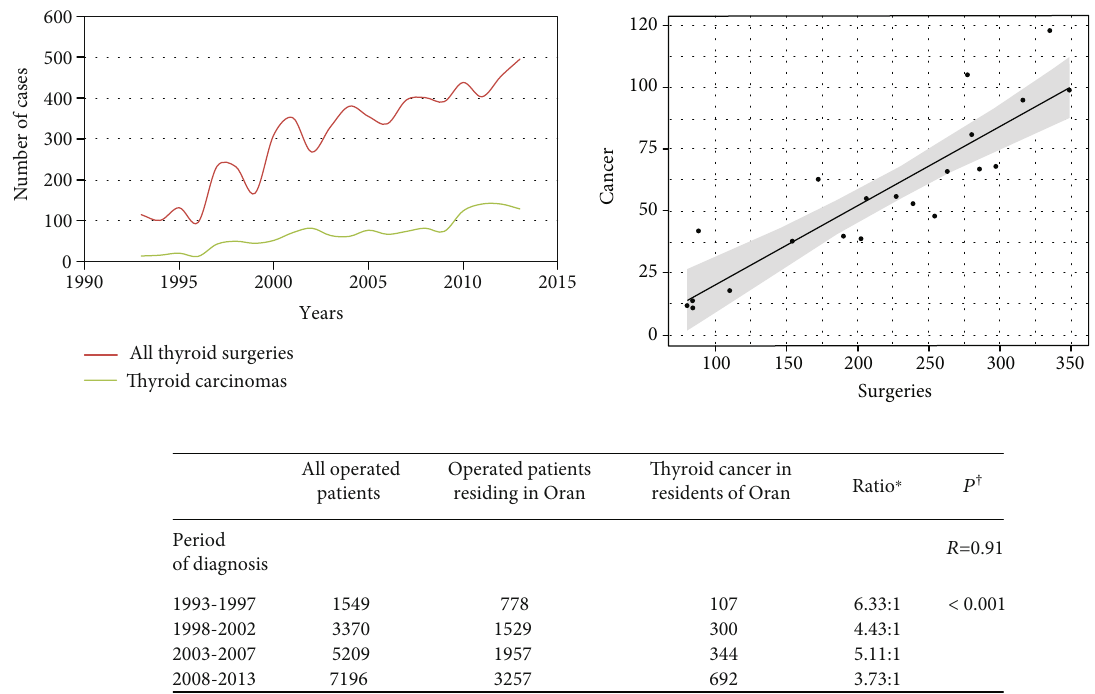
Abbreviations : PTC, papillary thyroid carcinoma ; FTC, follicular thyroid carcinoma ; ATC, anaplastic thyroid carcinoma ; MCT, medullary thyroid carcinoma ; NOS, not otherwise specified